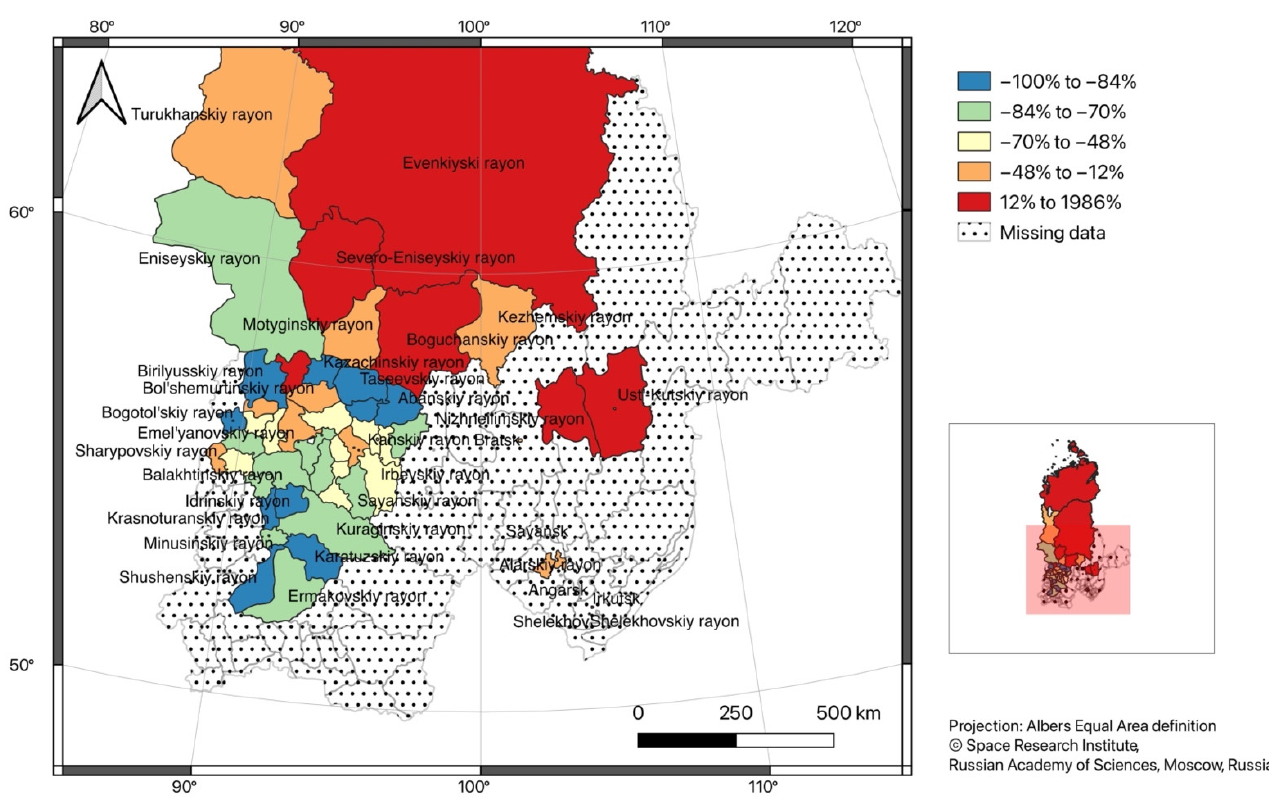
Figure 1. Percentage change in the total emissions of air pollutants across the municipalities of the Angara–Yenisey microregion between 2010 and 2020. Source: Rosstat data. Made using QGIS version 3.16 [54]. Administrative boundaries are retrieved from GADM project (https://gadm.org (accessed on 25 July 2021)) and then updated by the authors to comply with the current administrative division of northern territories of Krasnoyarsk Krai.